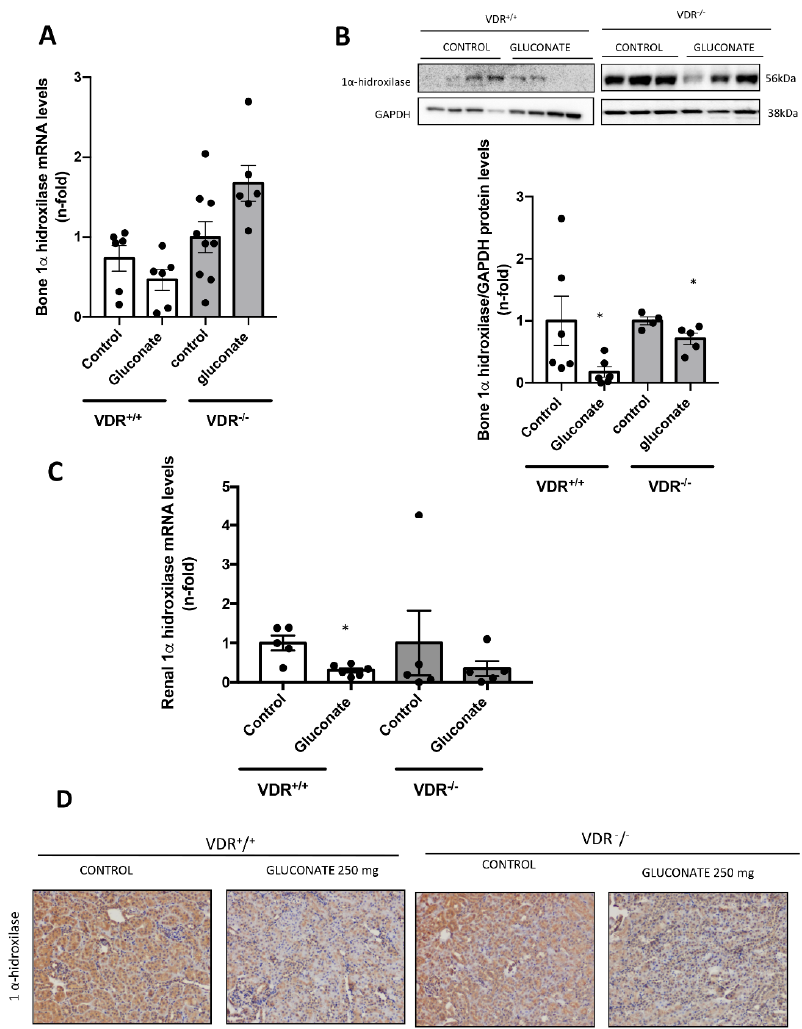
Figure 6. Study of the effects of calcium modulation on the gene and protein expression of 1 α -hydroxylase in bone and renal tissue. PTX VDR +/+ or VDR − / − mice were submitted to thyro-parathyroidectomy (T-PTX) by electro-cauterization. After this surgery, we infused mice with constant levels of PTH by osmotic minipumps. ( A ) Bone gene expression of 1 α -hydroxylase in PTX VDR +/+ or VDR − / − mice by RT PCR. ( B ) The bone protein expression of 1 α -hydroxylase in PTX VDR +/+ or VDR − / − mice by Western Blot. ( C ) Renal gene expression of 1 α -hydroxylase in PTX VDR +/+ or VDR − / − mice